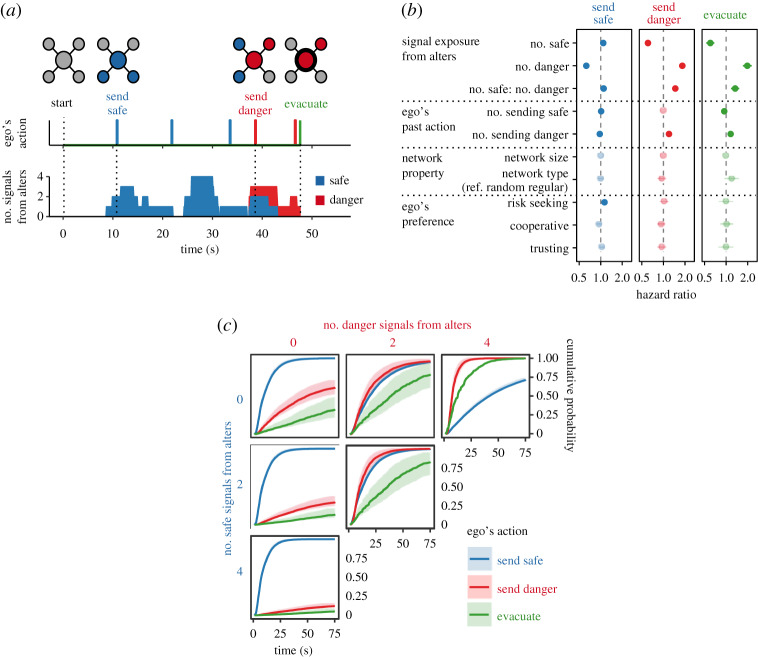
Individual behaviours upon exposure to neighbours' signals. (a) An example of an individual taking action upon receiving a series of signals from neighbours. The figures are snapshots with the local network of a player when they first send safe signals, send danger signals and eventually evacuate. (b) The hazard ratios are estimated by Cox models with time-varying covariates of neighbour's signals, incorporating random effects for individuals. The model includes control variables of subject's past action, network properties and subject's psychological features (see Material and methods for full models and details). Error bars are 95% confidence intervals. Dark-colour plots for significant coefficients with 95% confidential intervals. (c) Cumulative probability of sending a safe signal, sending a danger signal and evacuating, over time, while controlling for signal exposure from neighbours, estimated by the model. Error bars are 95% confidence intervals. The curves show the probability of taking the action at a given time if a player receives the indicated signal combination from his or her neighbours. Safe signals in blue, danger signals in red and evacuation in green (see electronic supplementary material, figure S5 for more details). (Online version in colour.)